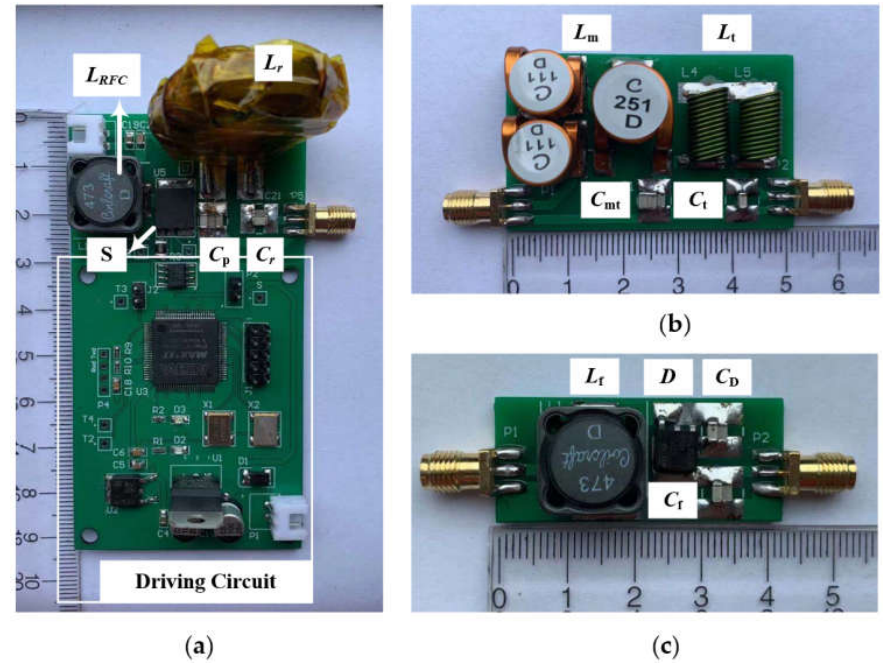
Figure 9. Experimental PCBs: ( a ) Class-E PA; ( b ) double-L-type IMN; ( c ) Class-E Rectifier.